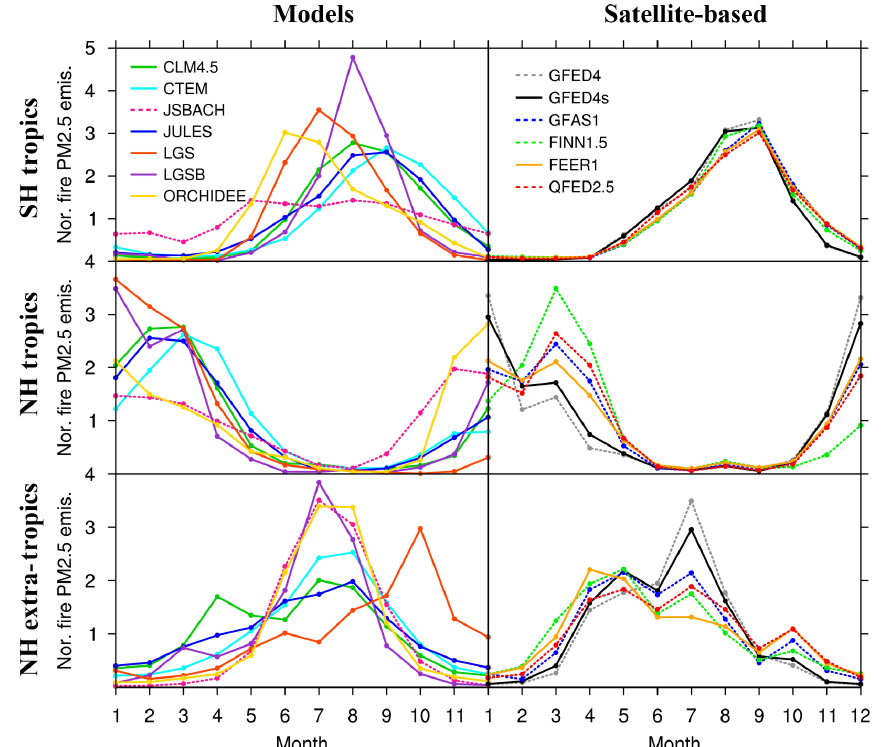
Figure 4. Seasonal cycle of fire PM 2 . 5 emissions normalized by the mean from FireMIP models and satellite-based products averaged over 2003–2008 in the Southern Hemisphere (SH) tropics (0–23.5 ◦ S), Northern Hemisphere (NH) tropics (0–23.5 ◦ N), and NH extra-tropics (23.5–90 ◦ N). Fire emissions from LPJ-GUESS-GlobFIRM and MC2 are updated annually and are thus not included